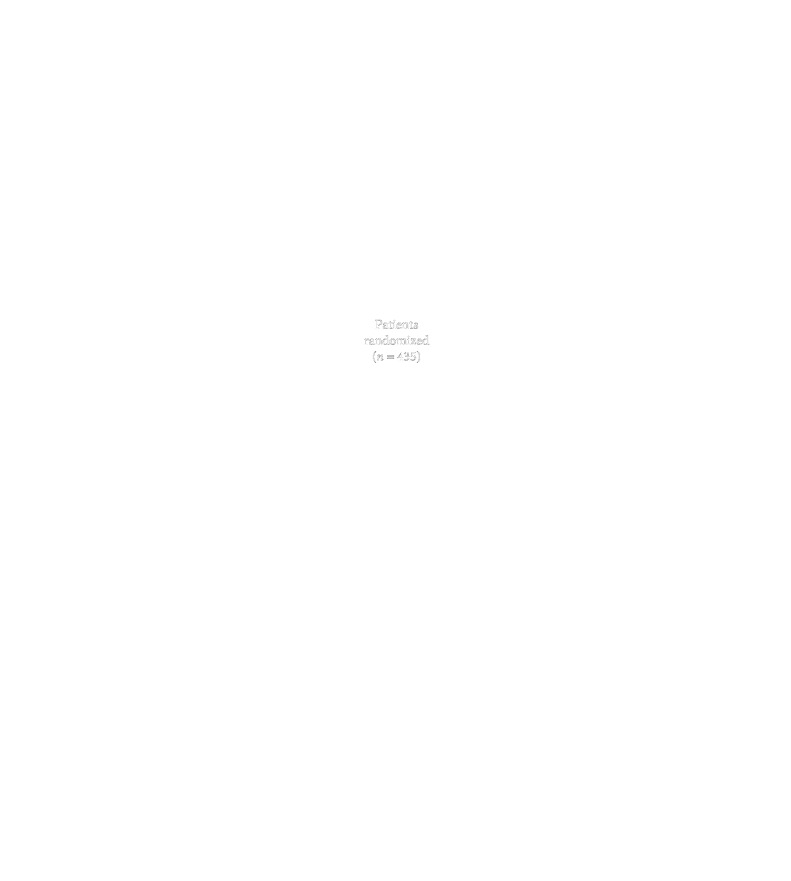
Patients' disposition and primary reason for discontinuation (pooled data from ADAPT-1 and ADAPT-2, all randomized patients). AE = adverse event; EC = entry criteria; LTFU = lost to follow-up; SC = patients' choice; WC = withdrawn consent.